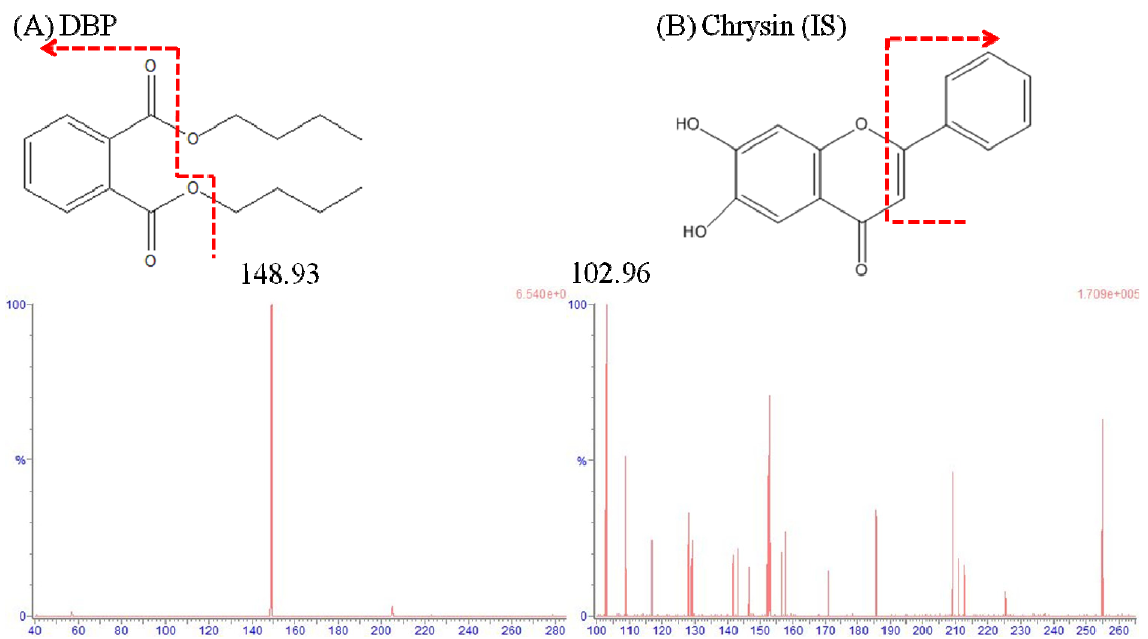
Figure 1. Representative product ion mass spectra and chemical structures of ( A ) Dibutyl phthalate (DBP) and ( B ) chrysin (internal